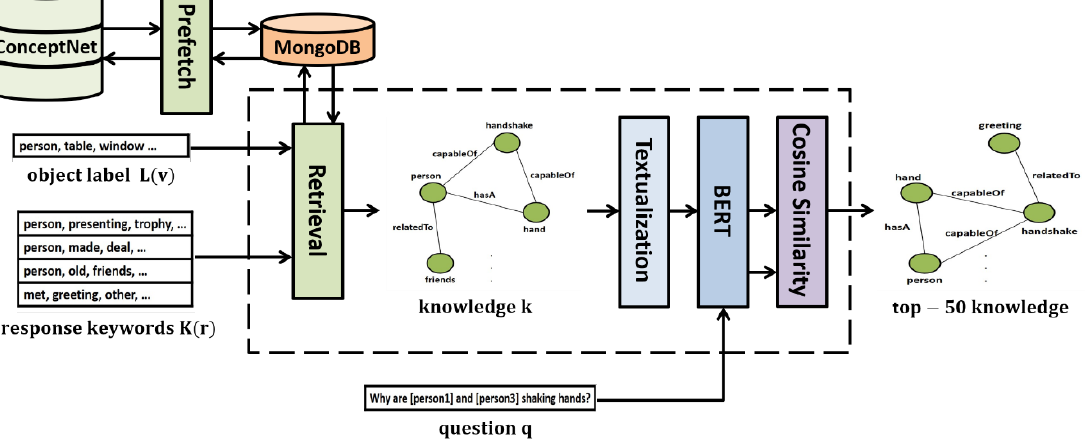
Figure 3. Knowledge extraction module (KEM).